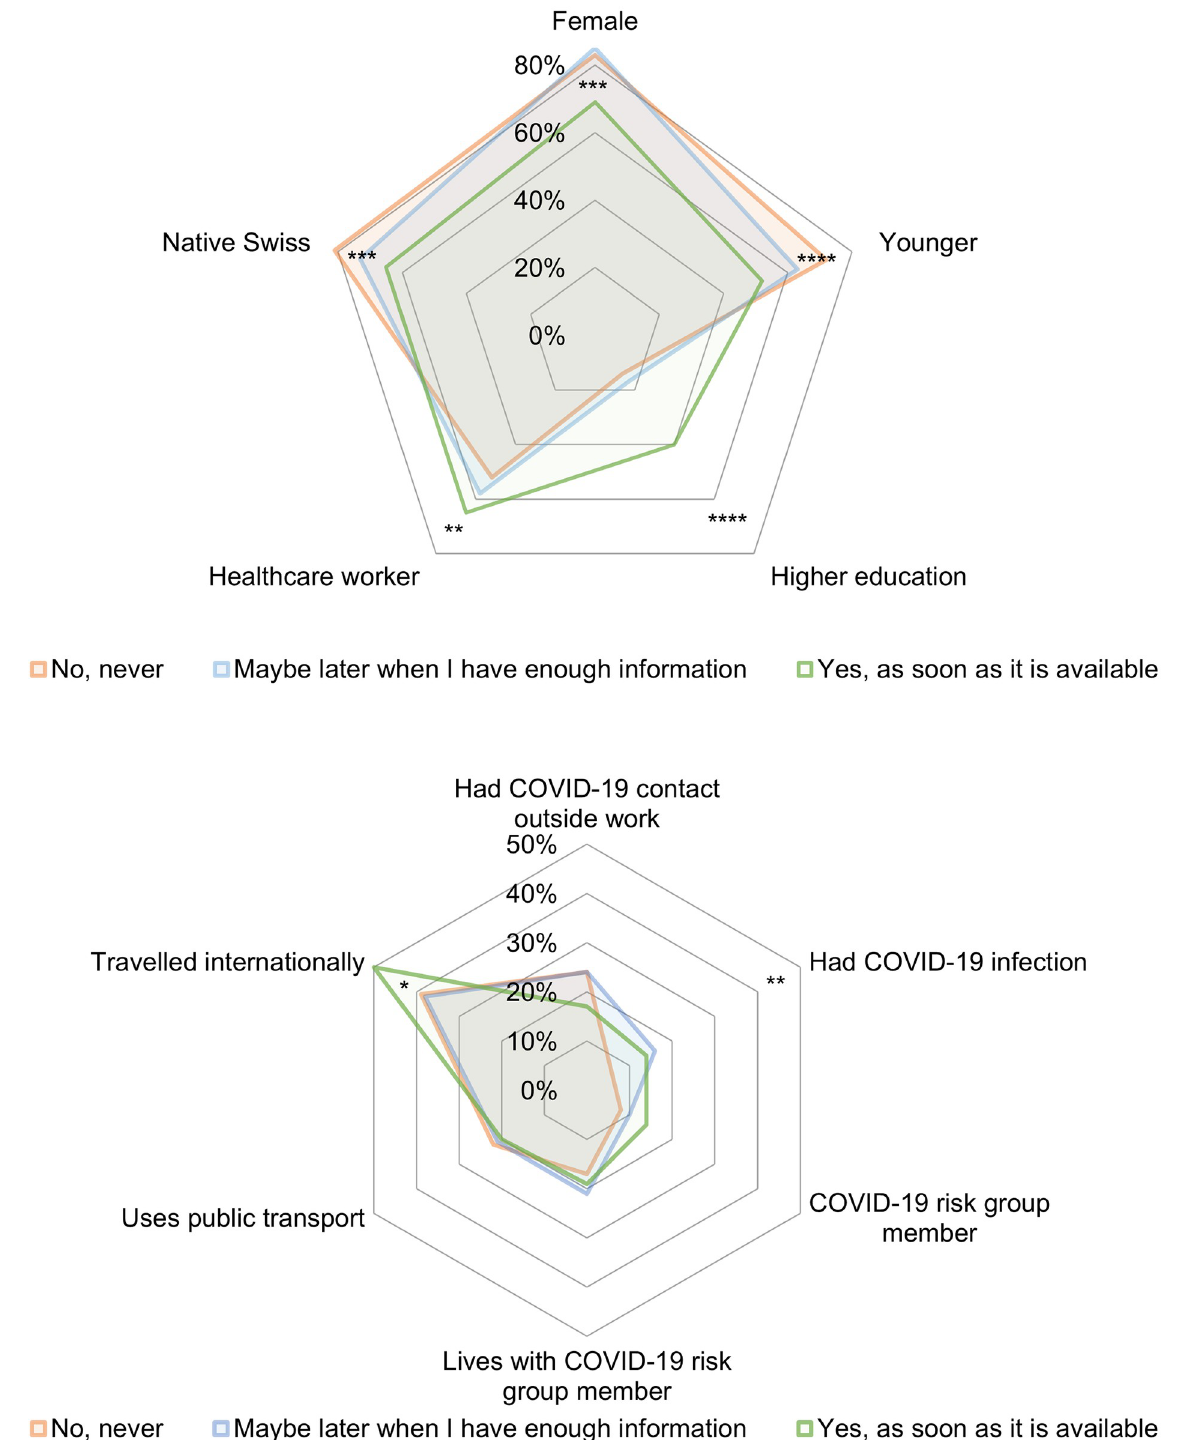
Fig 2. Descriptive statistics of individual and situational characteristics by vaccination willingness. ( a ) Individual characteristics ( b ) Situational factors. Survey question (n = 915): “Assuming that the COVID-19 vaccination is free of charge and approved in Switzerland, would you like to be vaccinated?” All variables are binary. For each binary characteristic, we show the percentage of respondents within each of the three groups. The statistical differences using two-sided t-tests for independent sub-samples between the “Yes, as soon as it is available” group and the “No, never” group are depicted as follows: � p < 0.1, �� p < 0.05, ��� p < 0.01, ���� p <